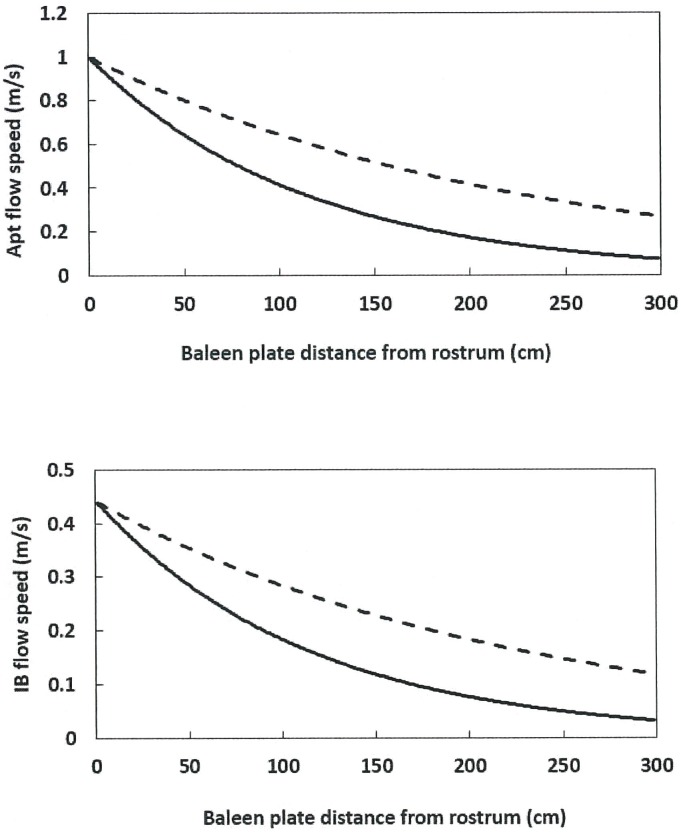
BHC flow speeds versus mean tongue wall distance from baleen (Din).Shown are values for widths of Din = 0.5m (continuous line) and 1.00m (dashed line), in the case of a 10m whale swimming at Uwhale = 1.0m/s. The rest of the inputs in both frames are as follows: dbaleen = 0.01m, cbaleen = 0.07m, hHT = 1.5m and C = 0.44.